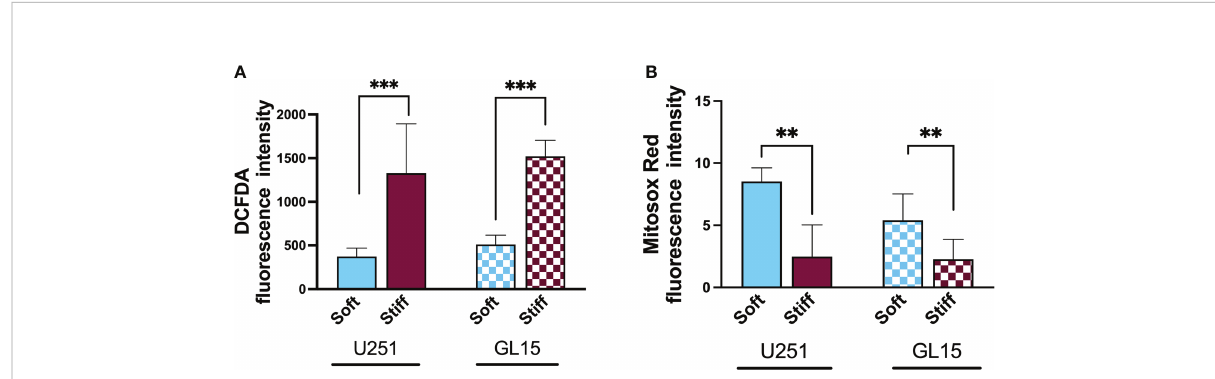
FIGURE 5 Substrate-in fl uenced ROS generation in GBM cells. (A) Bar graphs showing the change of intracellular ROS production, detected with DCF-DA, in U251-MG and GL15 cells. (B) Bar graphs showing the change of mitochondrial ROS production in U251-MG and GL15 cells. Data presented as mean ± S.D.; n = 3 independent experiments for each condition. One-way Anova, applied for each cell line; *p<0.05, **p<0.01,